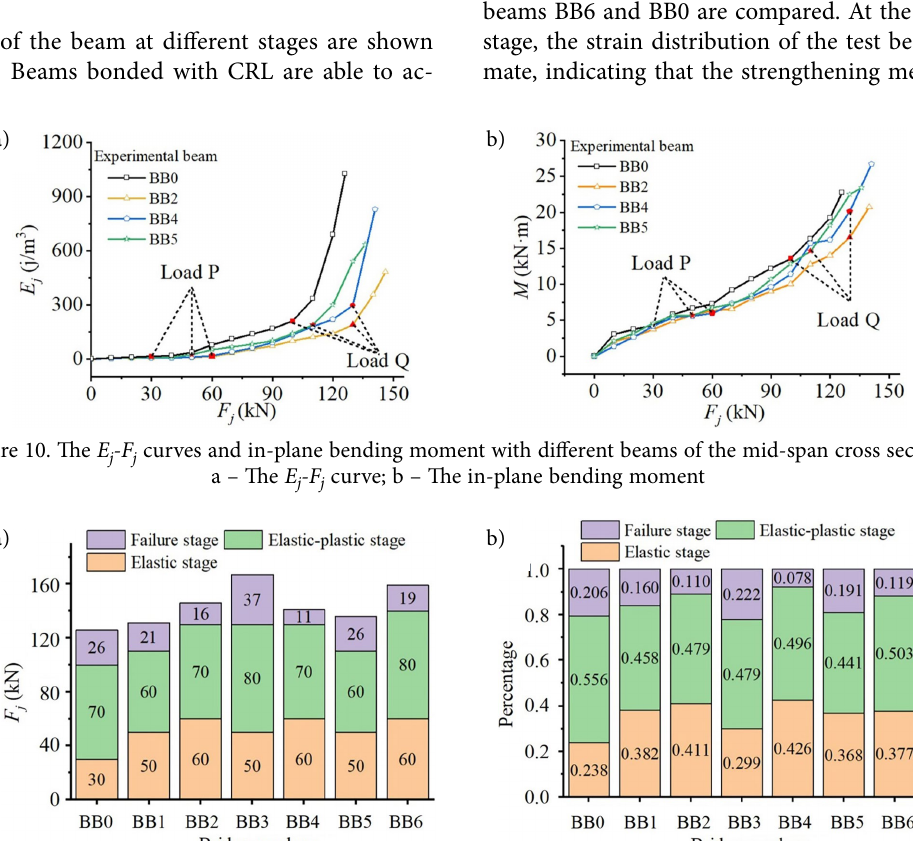
Figure 11. Three stages in the test: a – Loads at different stages; b – The proportion of the different loading